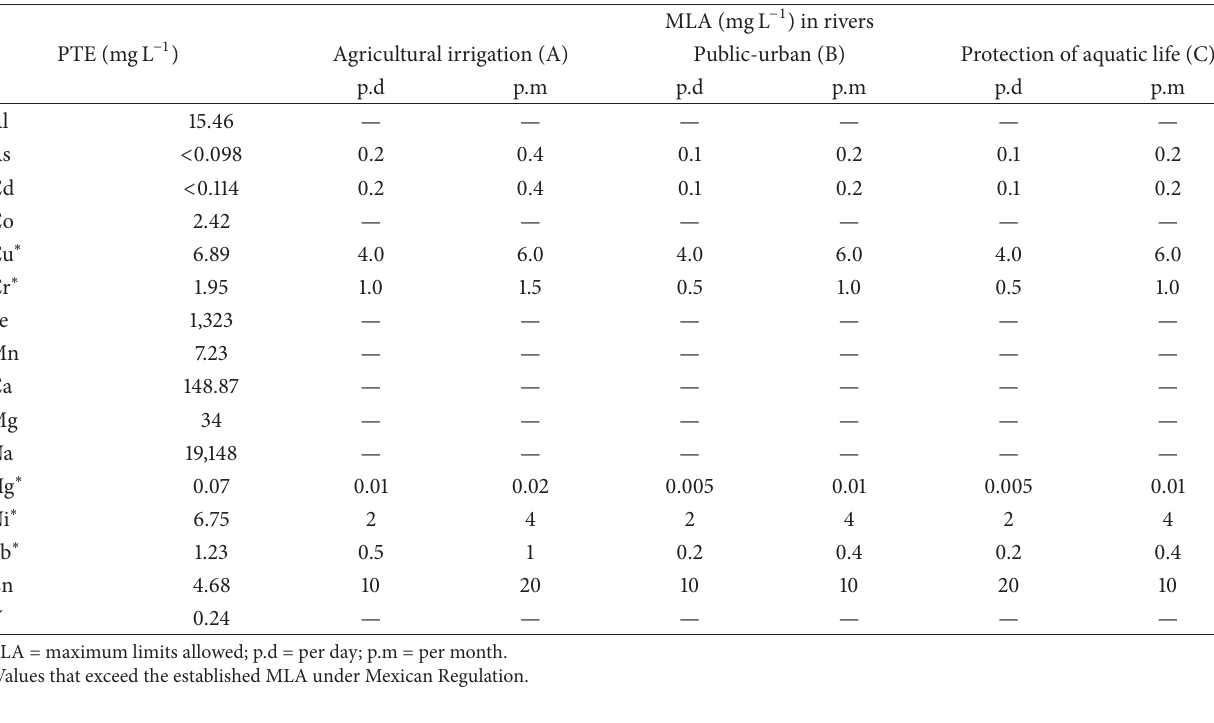
Table 2: Analysis of PTEs in spent caustics mixture.